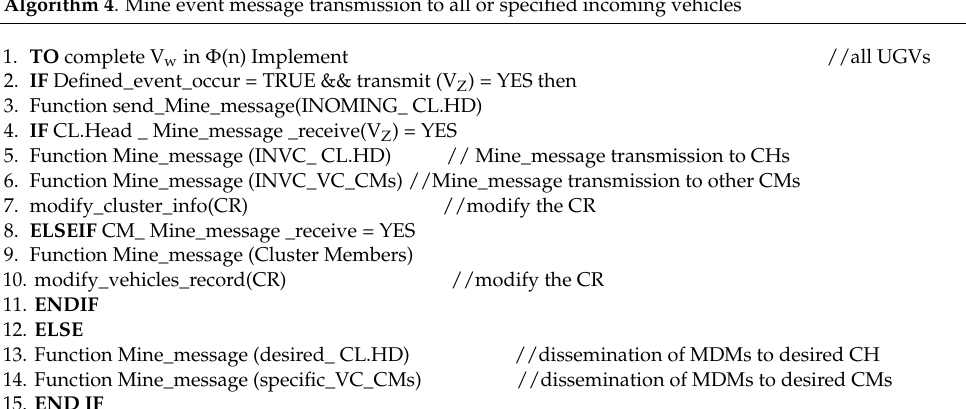
Algorithm 4 . Mine event message transmission to all or specified incoming